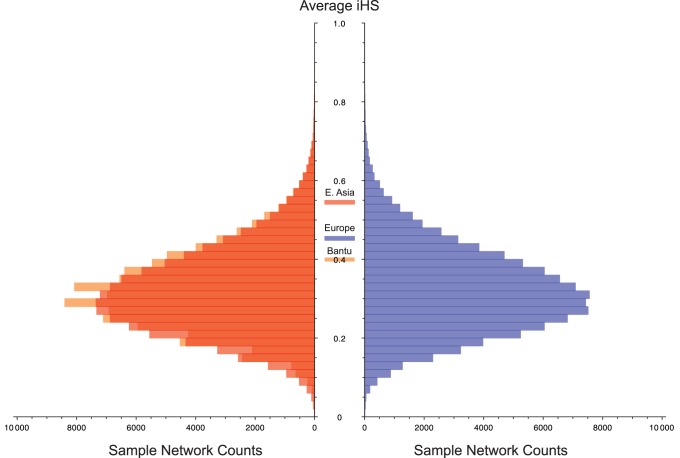
Within-continent mean normalized iHS values in CD network compared to genome-wide sample.Paired histogram illustrating mean iHS values of 100,000 sample networks of similar size to the CD network for European (Blue), East Asian (Red), and Bantu (Orange) samples from HGDP. Mean iHS values for the CD network in each region are indicated in the central margin of the histogram. Only the average value for East Asian samples is significant (p = 0.031). Networks were sampled requiring a minimum physical distance of 2 Mb between any two loci on the same chromosome.